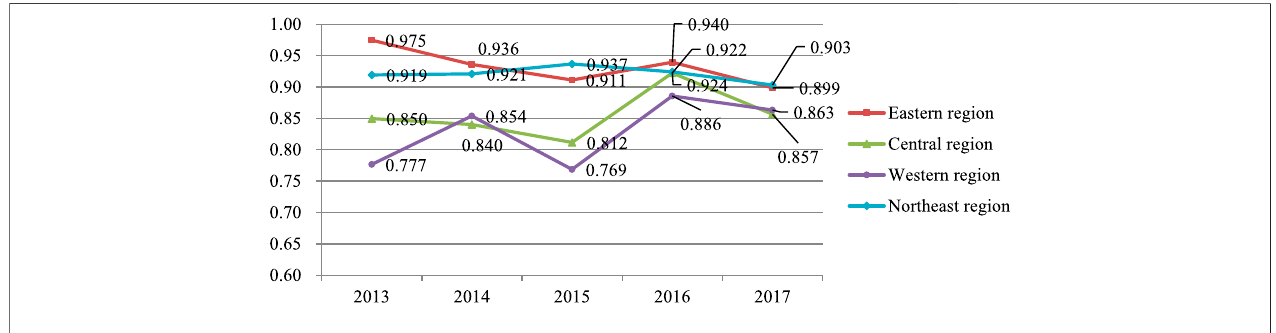
FIGURE 7 | Ef fi ciency values of installed capacity in various regions by year.